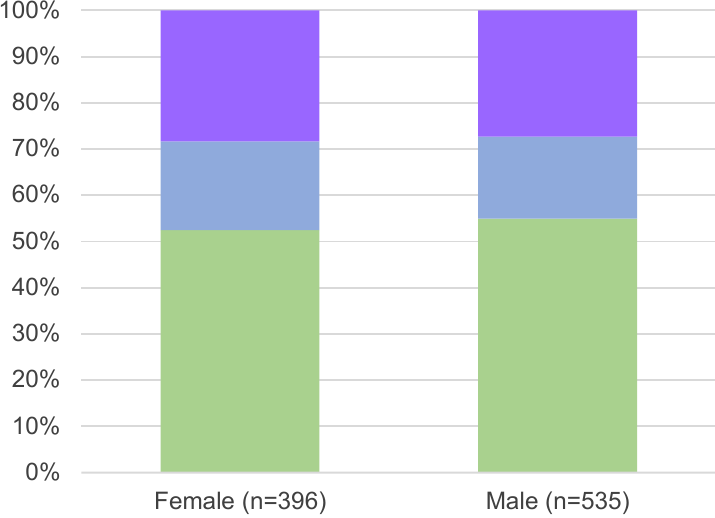
Figure 16: Distribution of fingerspelling-related tokens by nativisation category (N only) and gender